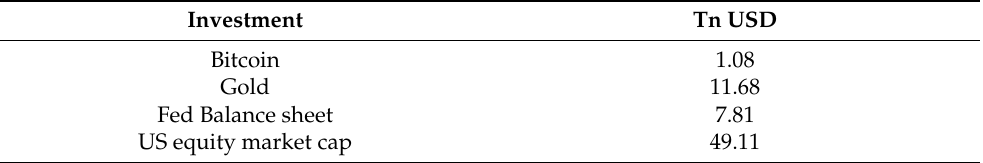
Table 6. The Market capitalization of Bitcoins, S&P 500, gold, and Treasury